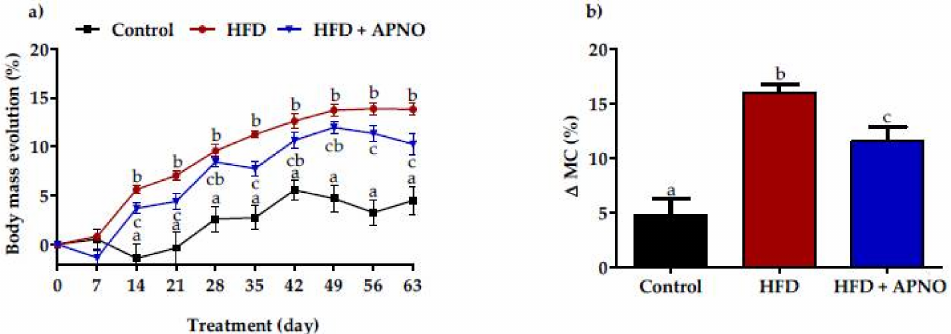
Figure 1. ( a ) Body mass evolution and ( b ) total body weight gain of normolipidemic rats (Control) and high-fructose diet-induced hyperlipidemic rats treated with water (HFD) or A. phalerata nut oil (1.2 mg · Kg –1 of body weight, HFD + APNO) for 63 days. Results are expressed as the mean ±